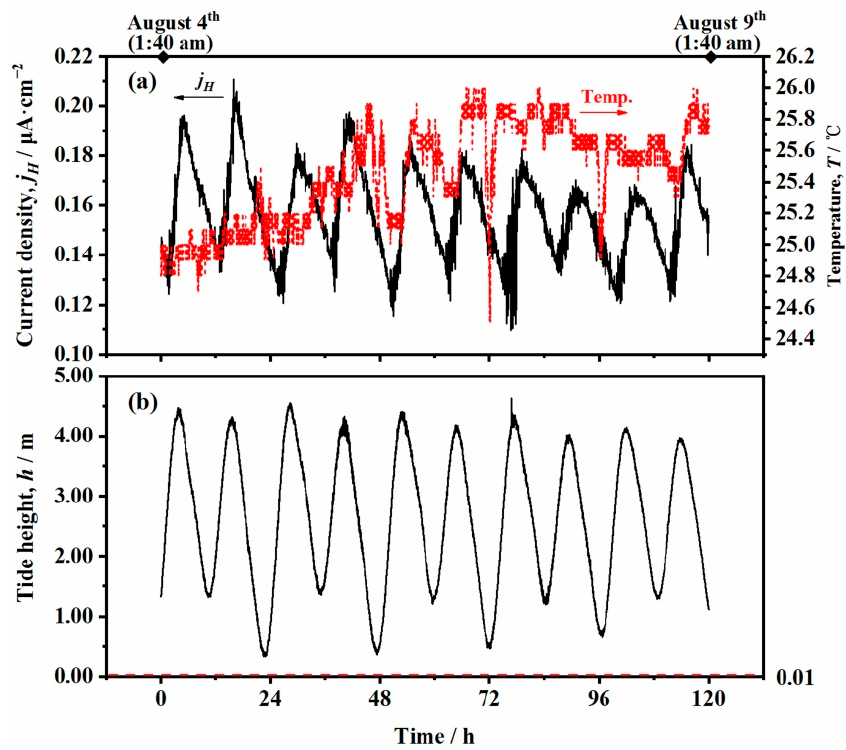
Figure 10. Time variations of the hydrogen permeation current density of the sensor exposed to the immersion zone and the corresponding temperature ( a ), as well as tidal changes ( b ), from 4 August to 9 August during outdoor hydrogen permeation test.